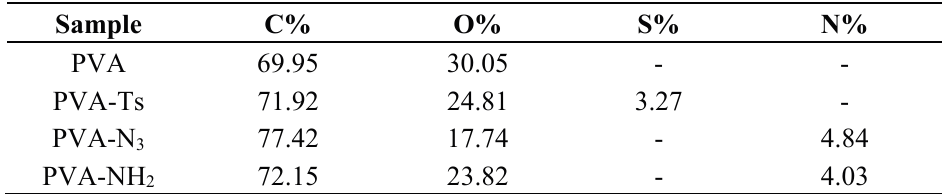
Figure 3. XPS spectra of ( a ) unmodified PVA; ( b ) tosylated PVA (PVA-Ts); ( c ) azidated PVA (PVA-N 3 ) and ( d ) PVA after click reaction with propargylamine (PVA-NH 2 ). Table 1. Elements compositions of unmodified PVA and PVA after each chemical functionalization.